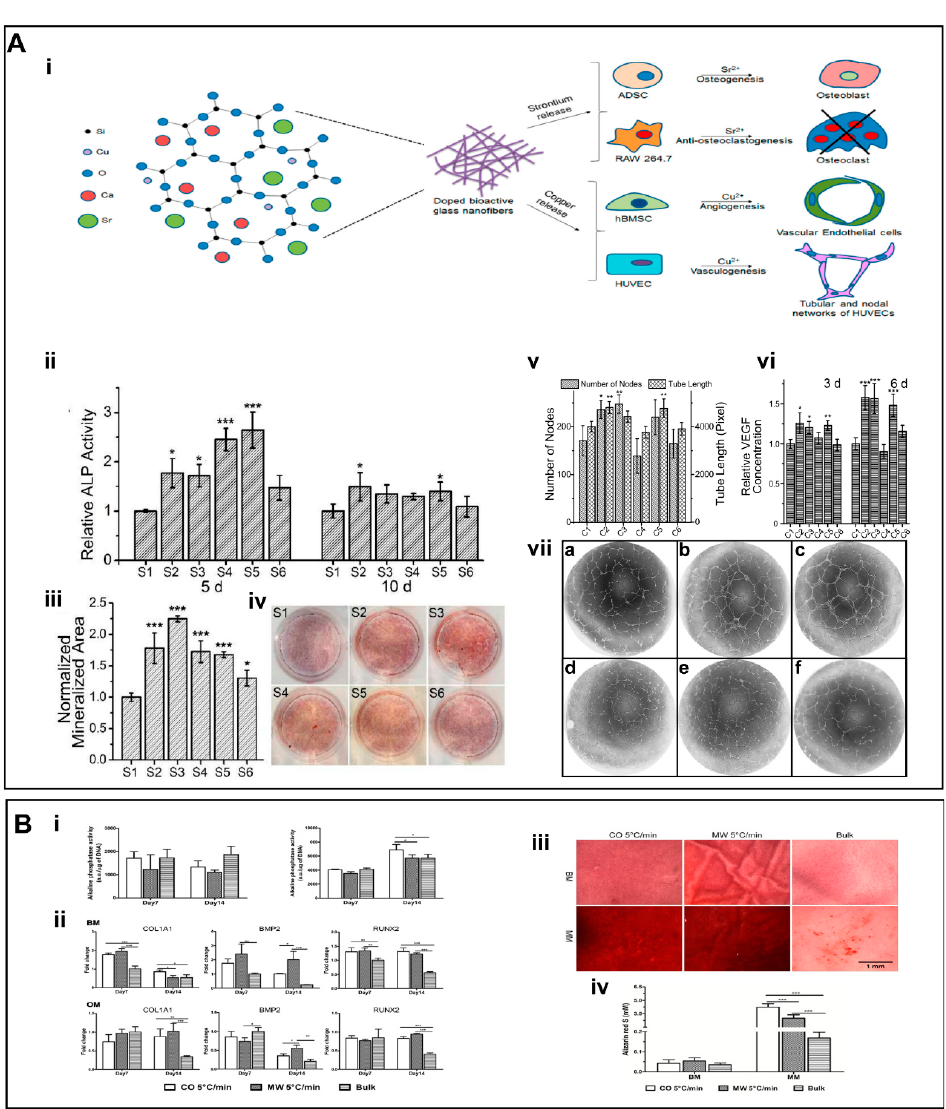
Figure 2. ( A ) (i) Schematic representation of the strategy for the action of Cu and Sr ions. (ii) The ALP activities of BG nanofibers. (iii) The mineralized area was stained by alizarin red at day 15. (iv) Alizarin red staining of different groups. (v) Quantification of the number of nodes and tube length of human umbilical vein endothelial cells (HUVECs) cultured on the Matrigel for 16 h. (vi) Quantification of secreted vascular endothelial growth factor (VEGF) from human bone marrow mesenchymal stem cells (hBMSCs) for different groups. (vii) (a–f) Inverse color images of the vascularization of HUVECs cultured in the presence of the extraction media from different glass nanofiber. ( B ) (i) ALP activity. (ii) Gene expression analysis for COL1A1, BMP2, and RUNX2. (iii) The formation of mineralized ECM was ascertained by staining the scaffolds with alizarin red S. (iv) Quantitative analysis of the mineral deposits per scaffold by alizarin red S staining at day 28. ( A ) (i–vii) Reproduced with permission from reference [68]. Copyright 2017, American Chemical Society (ACS) publishers. ( B ) (i–iv) reproduced with permission from reference [69]. Copyright 2016, American Chemical Society (ACS) publishers. Asterisks indicate significant differences ( p <